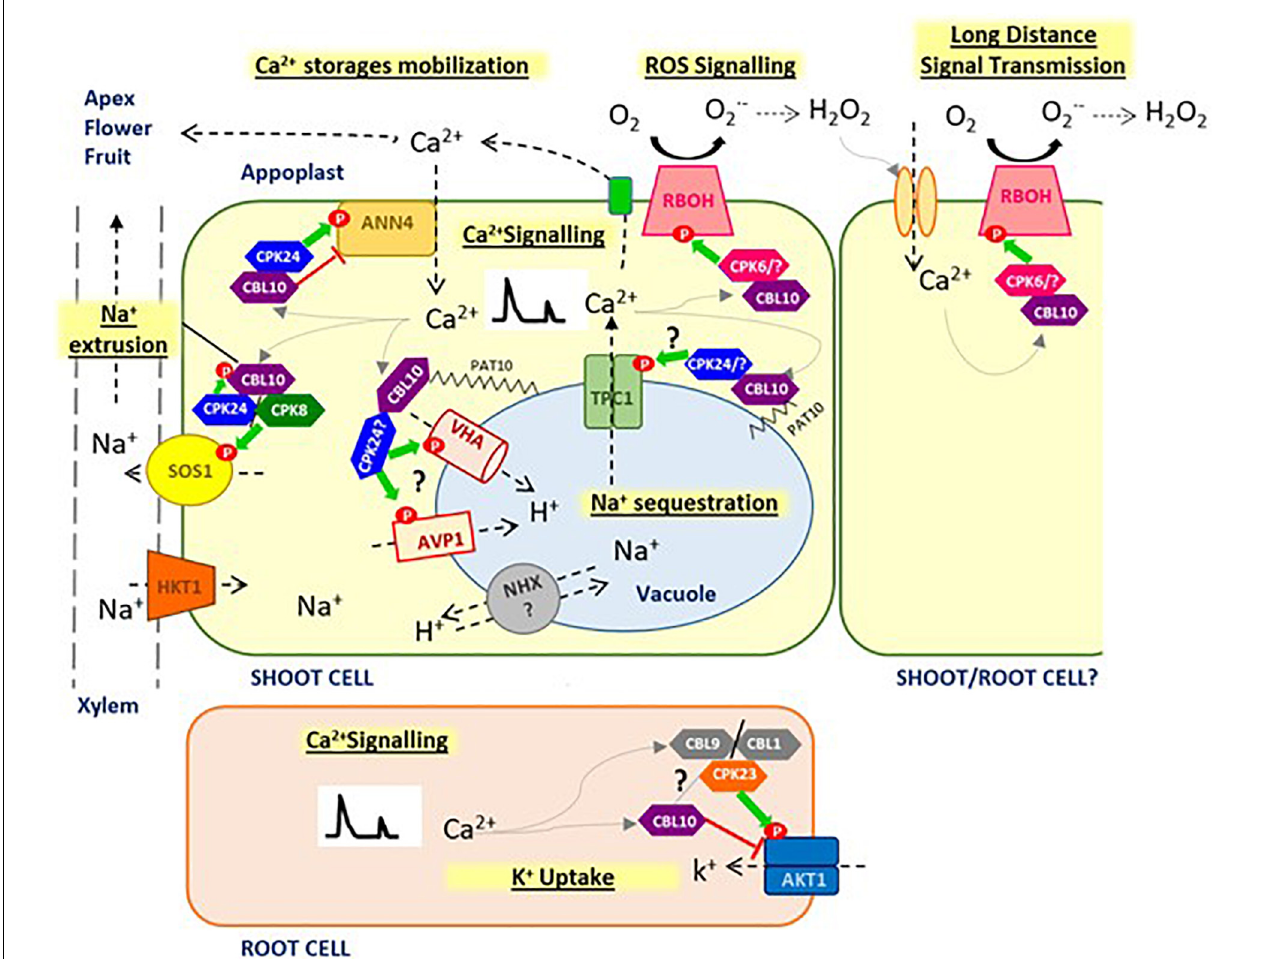
FIGURE 1 | Proposed model for CBL10 function. CBL10 functions as a crucial regulator in Na + homeostasis under salt stress conditions, interacting with CIPK24 (SOS2) and CIPK8, and activating SOS1 pathway at plasma membrane for Na + extrusion to apoplast and may be interacting with vacuolar H + pumps (AVP1, VHA) facilitating Na + sequestration into the vacuole. CBL10 also plays a key role in Ca 2 + homeostasis, which in turn hints at this Ca 2 + -sensor protein as a key master regulator of stress signaling in plants, involved in generation and fine tuning of Ca 2 + signatures in the cytoplasm, through the coordination of different Ca 2 + channels at different cellular localizations, such as plasma membrane (AtANN4) and probably tonoplast (TPC1), as well as in the cross-talk between Ca 2 + and ROS, through regulation of RBOHs activity, for a rapid long-distance transmission of signals. CBL10 seems also to be involved in mobilizing Ca 2 + stored in vacuole toward demanding tissues to compensate for Ca 2 + deficiency caused by salinity and thus allowing development of the meristem and reproductive organs. Finally, functions of CBL10 in root have been associated with K + uptake by negative regulation of AKT1 channel. Green arrows indicate activation by phosphorylation; red line indicates repression by direct interaction; gray arrows indicate activation by Ca 2 + , and question mark indicates hypothesized signaling processes that have not been verified